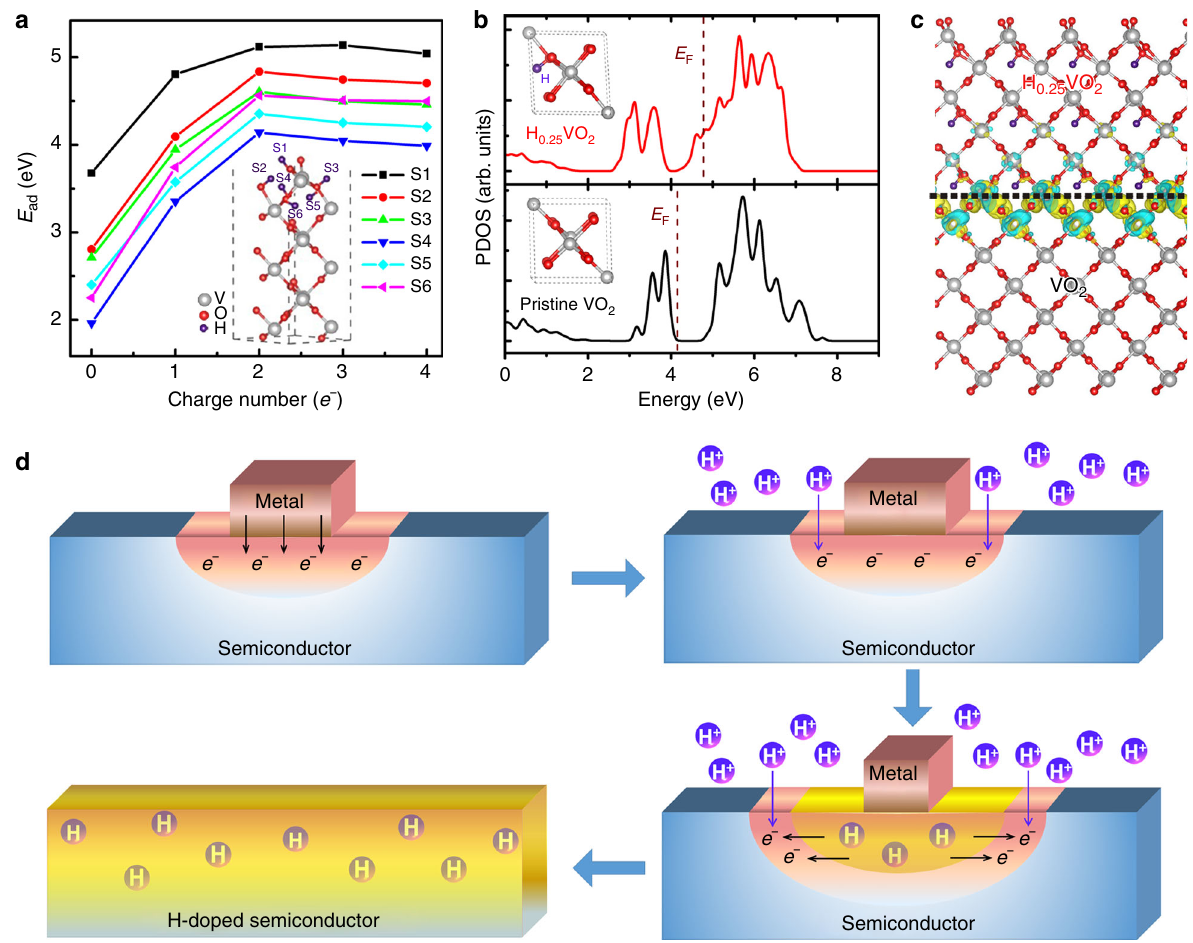
Fig. 4 Electron – proton co-doping mechanism. a Computed adsorption energies for a proton to six adsorption sites of VO 2 (020) surface, increased with the increasing amount of doped electrons. b Evolutions of V-3 d partial density of state (PDOS), suggest the change of semiconductor band gap in the insulated pristine VO 2 to the zero energy gap in H 0.25 VO 2 . Fermi level is marked with purple dashed lines. c Computed differential charge distribution at H 0.25 VO 2 – VO 2 interface, showing each H 0.25 VO 2 supercell donated ~2.06 e − to un-doped VO 2 . Here green and yellow bubbles represent hole and